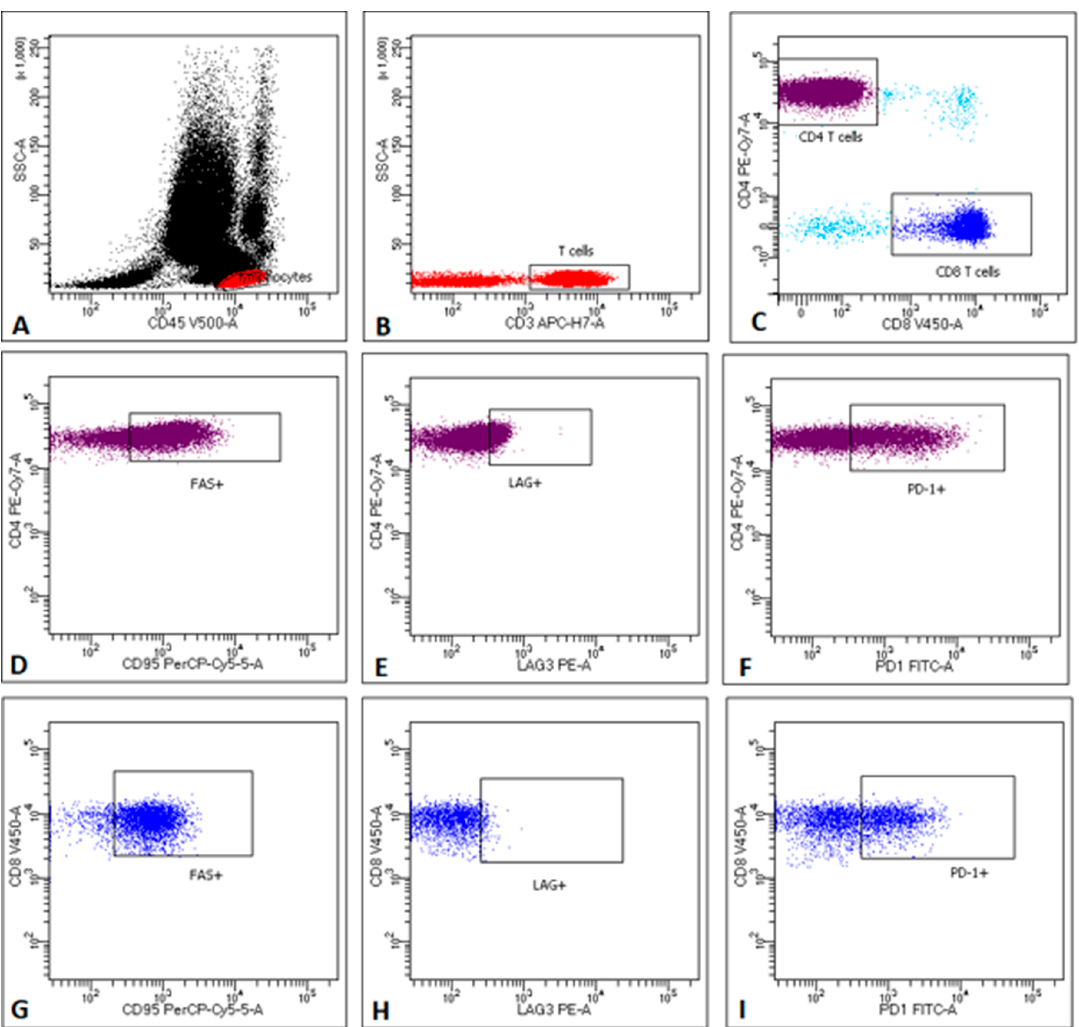
Figure A3. ( A – I ) The gating strategy for expression of Fas, PD-1, LAG3 on CD4 + T cells, and CD8 + T Figure A3. A-I ) The gating strategy for expression of Fas, PD-1, LAG3 on CD4+ T cells, and CD8+ T cells in cells in PB.